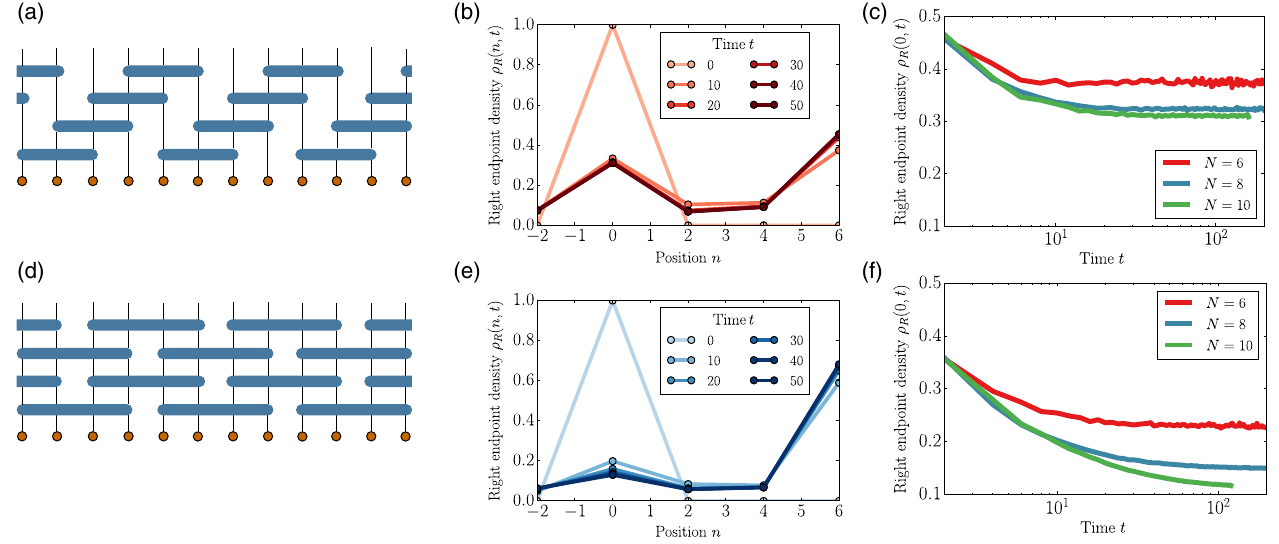
FIG. 18. Operator spreading of S z 0 ð t Þ for random circuits with gate sizes l ¼ 3 and 4. (a),(d) show the circuit geometries, slightly modified from the ones in the main text in order to ease numerical calculations. (b),(e) show the profile of right end point weights ρ n; t Þ at different times for a ten-site chain, for l ¼ 3 and l ¼ 4 , respectively. Both have a peak near the origin, but in the former case it R ð is much larger and stops decaying after a few time steps, while in the latter case it keeps decaying to longer times. Finite-size flow of the size of the peaks as a function of the time, shown in (c) and (f) indicates that while for l ¼ 3 the system saturates to a finite value, this is not the case for l ¼ 4 , where the long-time value scales to zero for large system sizes.